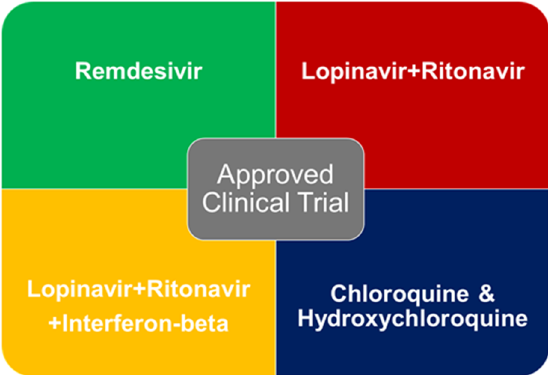
Figure 4. Four most promising drug candidates or combinations approved for clinical trial for COVID-19 treatment by WHO (announced on 18 March 2020).